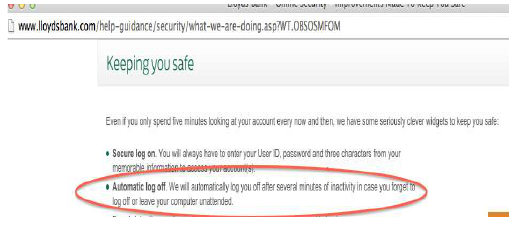
Figure 5-2: Automatic log